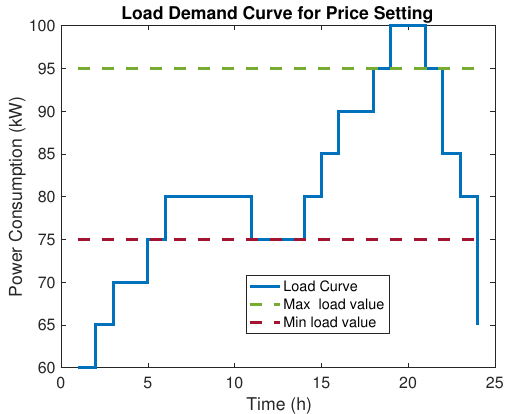
Figure 2. Typical Load Curve for Price